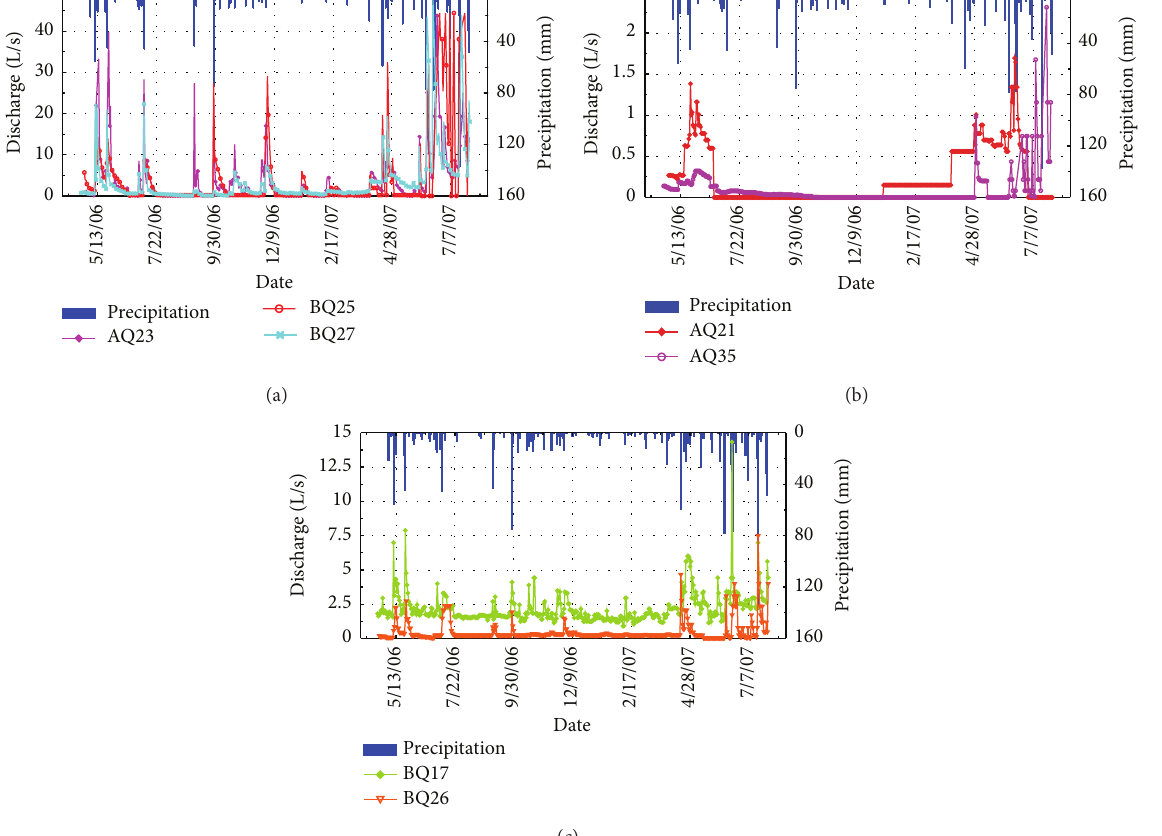
to the flow in patterns. Consequently, hydrograph of